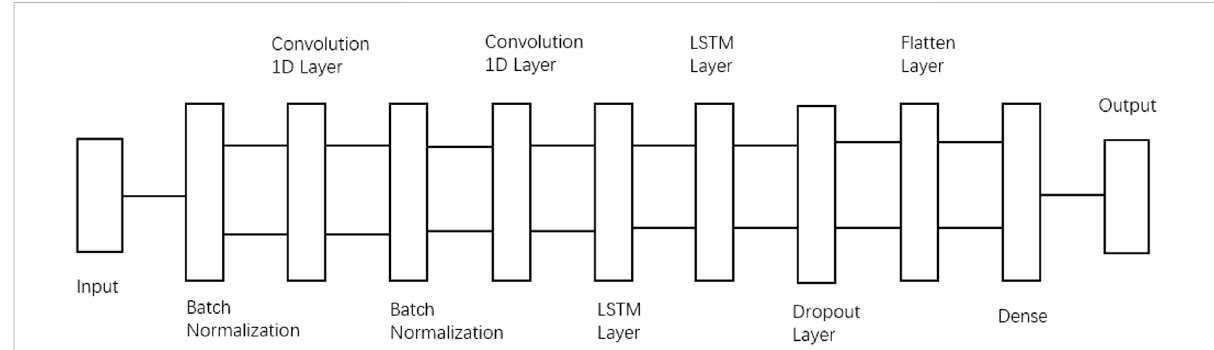
FIGURE 1 CNN-LSTM structure. Note: the data is transmitted via the input layer, and the convergence of the network structure is accelerated by Batch Normalizationlayer.Thenormalizedresultiscalculatedbythe1DconvolutionallayerandtheLSTMlayer.Followingthat,partofthedataisdiscarded through theDropout layerto preventover fi tting.The processing data is fl attenedand then passed throughthefully connected layer(Dense)andthe result is fi nally obtained through the output layer.